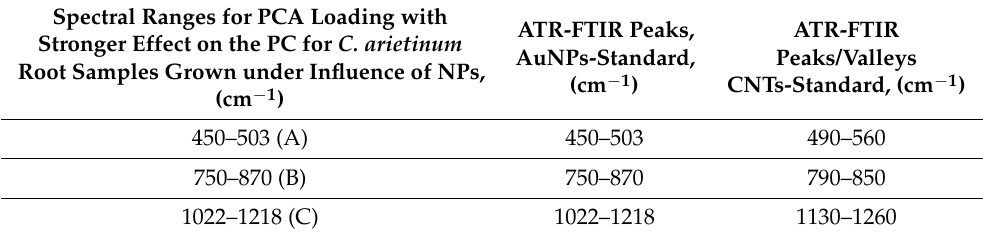
Table 1. Comparison of spectral ranges for PCA loading with stronger effect on the PC of the C. arietinum root samples grown under influence of NPs with the ATR-FTIR spectral peaks/valleys of AuNPs and CNTs standard samples. (A): Range A at 450–503 cm − 1 ; (B): range B at 750–870 cm − 1 ; and (C): range C at 1022–1218 cm − 1